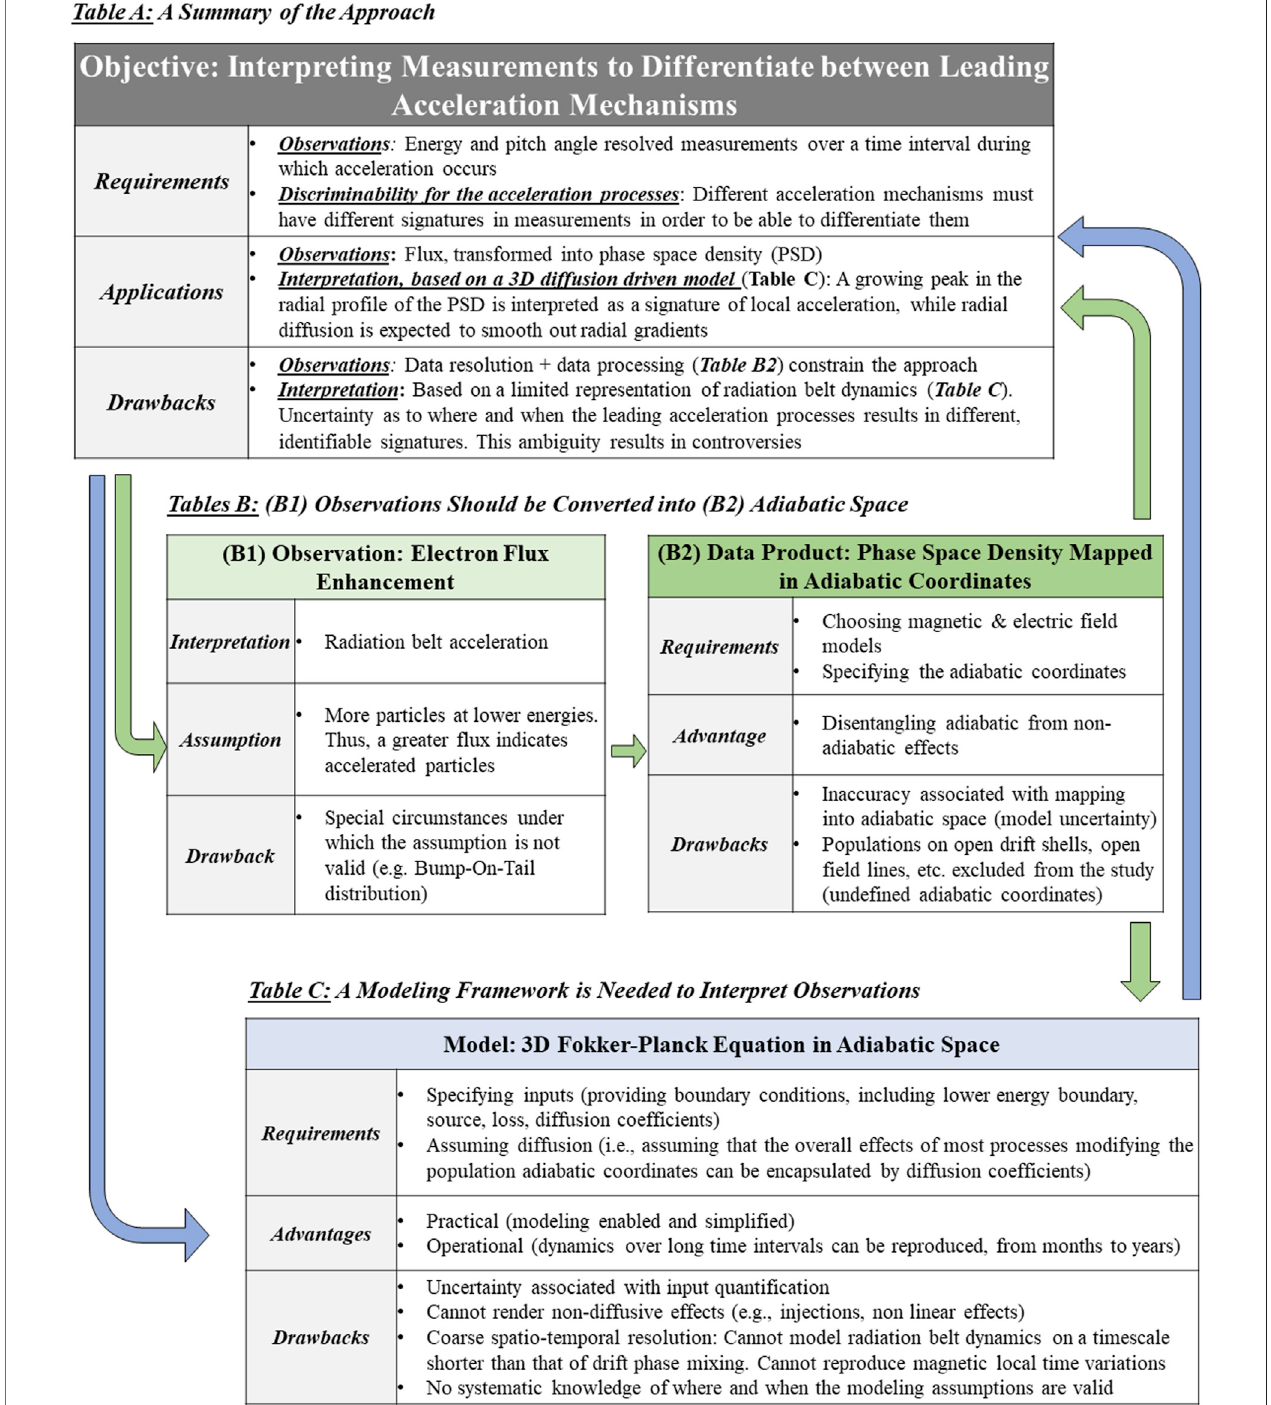
FIGURE 8 | A summary chart on the challenges associated with differentiating between the leading processes for electron radiation belt acceleration.